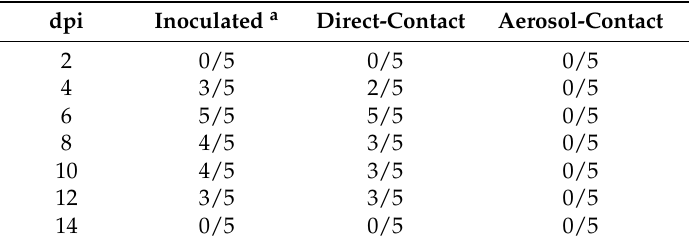
Table 6. Number of guinea pigs infected with rSD01-PA in transmission experiments. dpi Inoculated a Direct-Contact